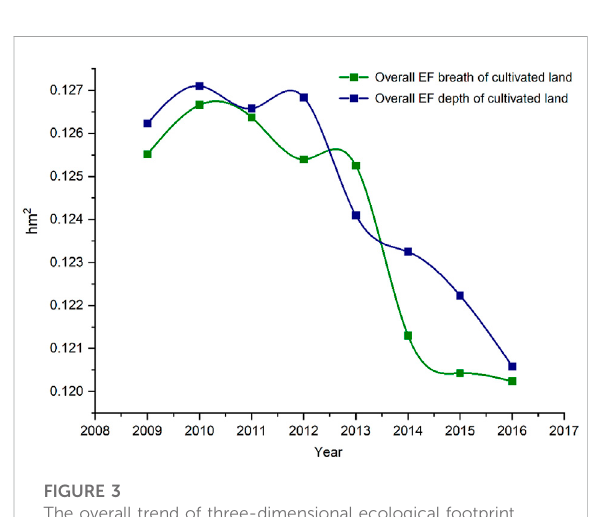
FIGURE 3 The overall trend of three-dimensional ecological footprint of cultivated land in Beijing-Tianjin-Hebei region.